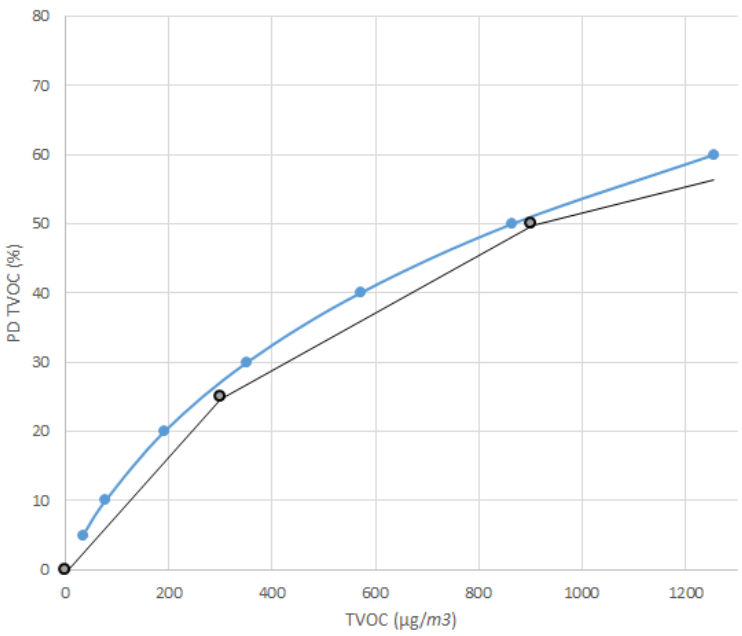
Figure 9. PD TVOC based on conversion from IAQI to the PD* scale and study of Weber ‐ Fechner theory.